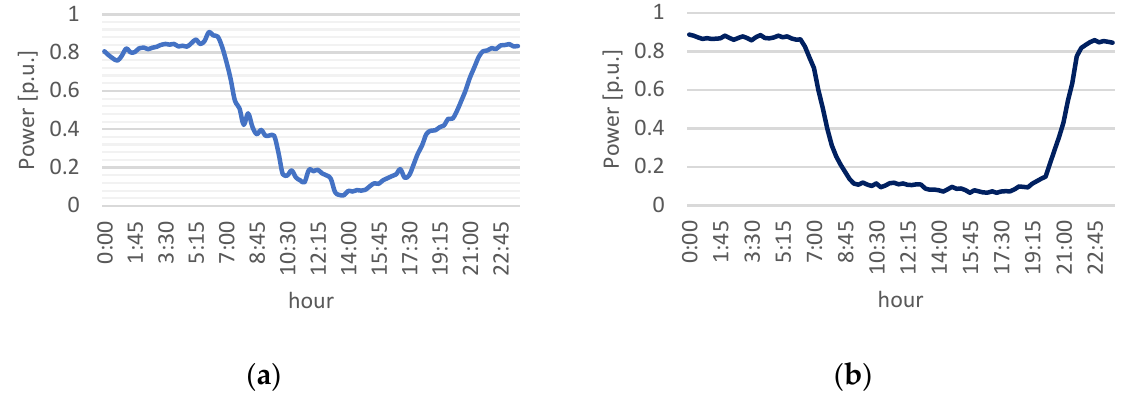
Figure 7. “U-type profile” obtained in industrial clients I1 and I2 (L-S-D) and commercial clients C1 and C2 (L-S-D). ( a ) The left curve corresponds to an industrial customer, and ( b ) the right curve corresponds to a commercial customer.